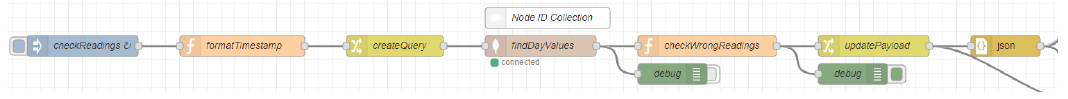
Figure 5. First part of the defense flow: analyzing the